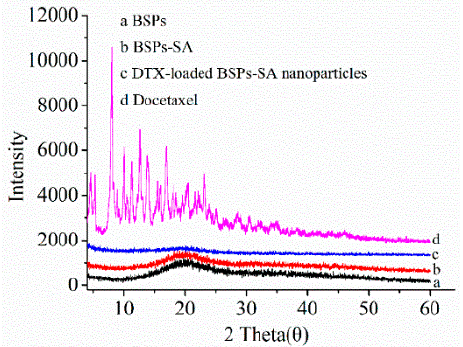
Figure 5. X-ray diffraction spectra (a: BSPs, b: BSPs-SA, c: DTX-loaded BSPs-SA nanoparticles, d: docetaxel).